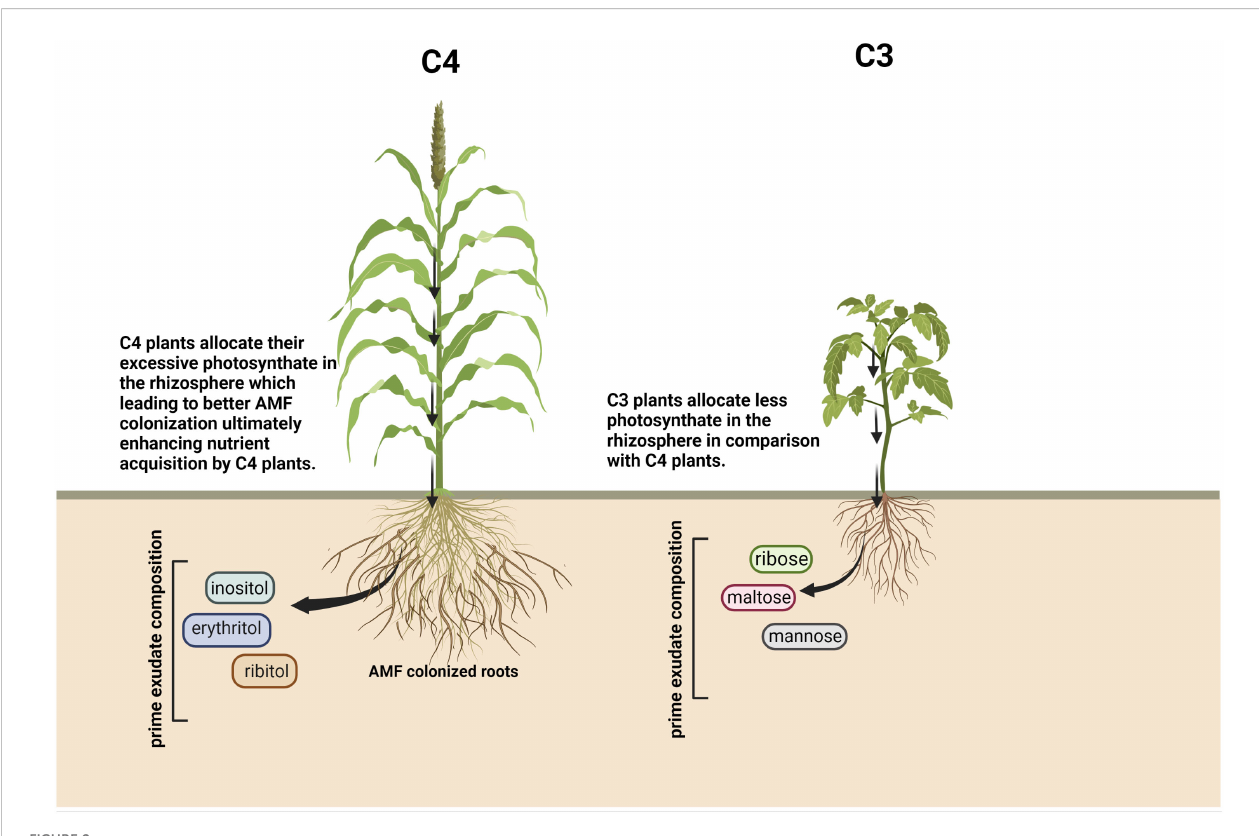
FIGURE 2 Schematic representation of root exudate compositions according to plants ’ mode of photosynthesis. Created with